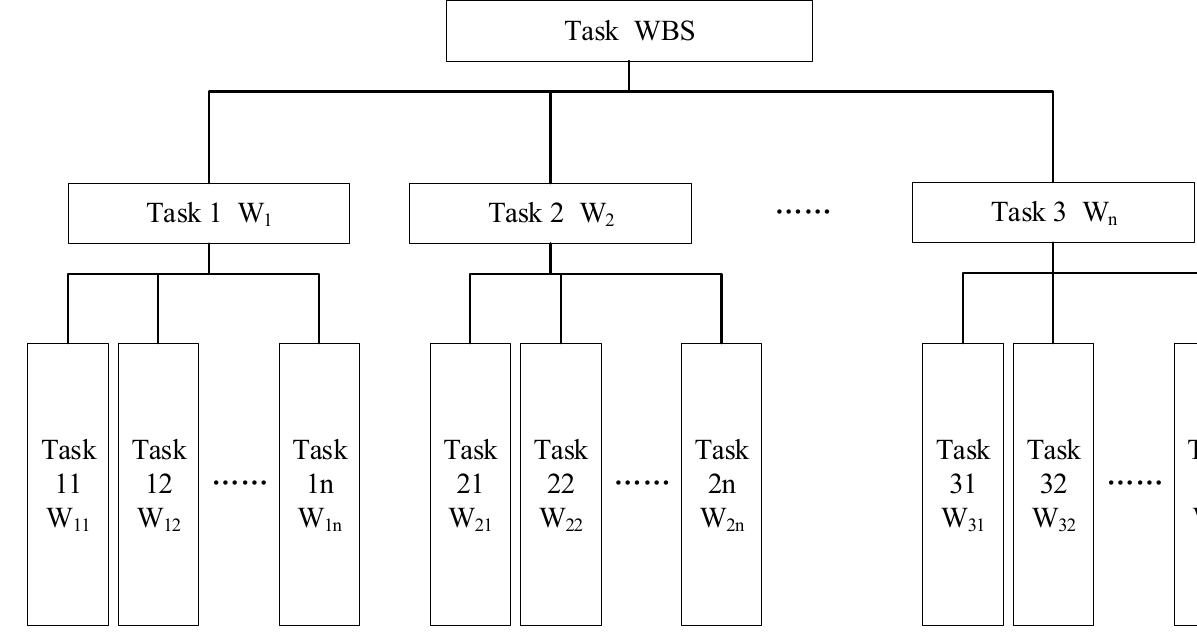
Figure 3. WBS structure example diagram.